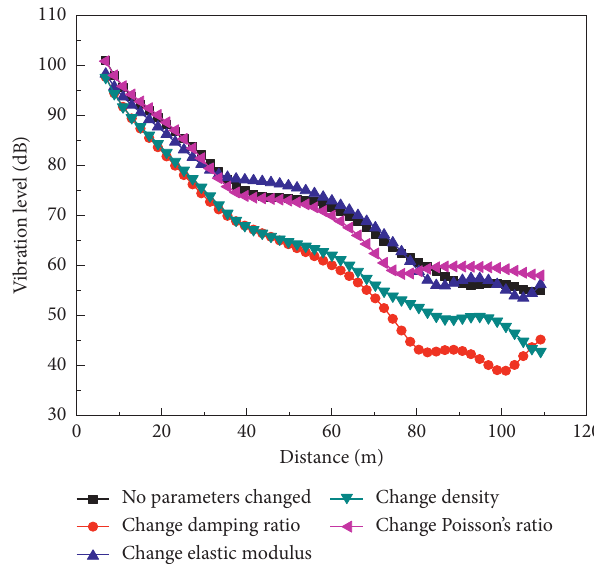
Figure 15: Parameter sensitivity analysis.